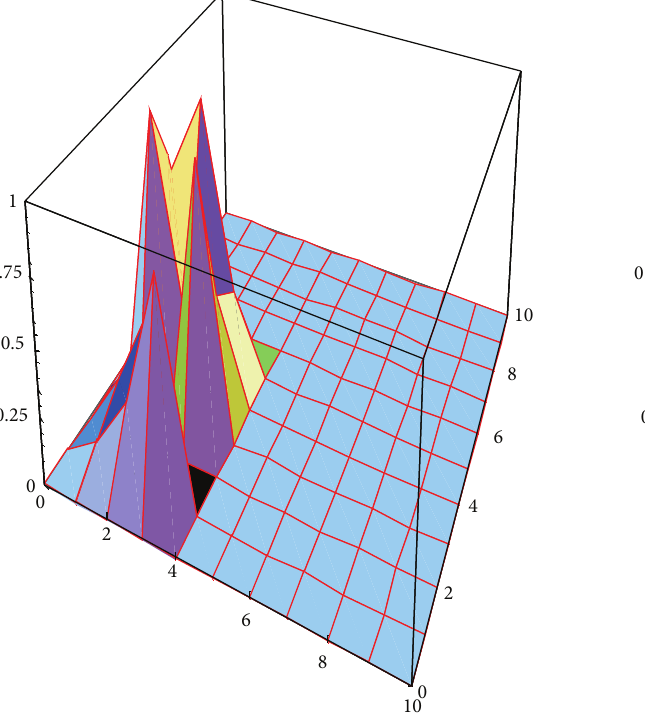
Figure 2: Fuzzy relation